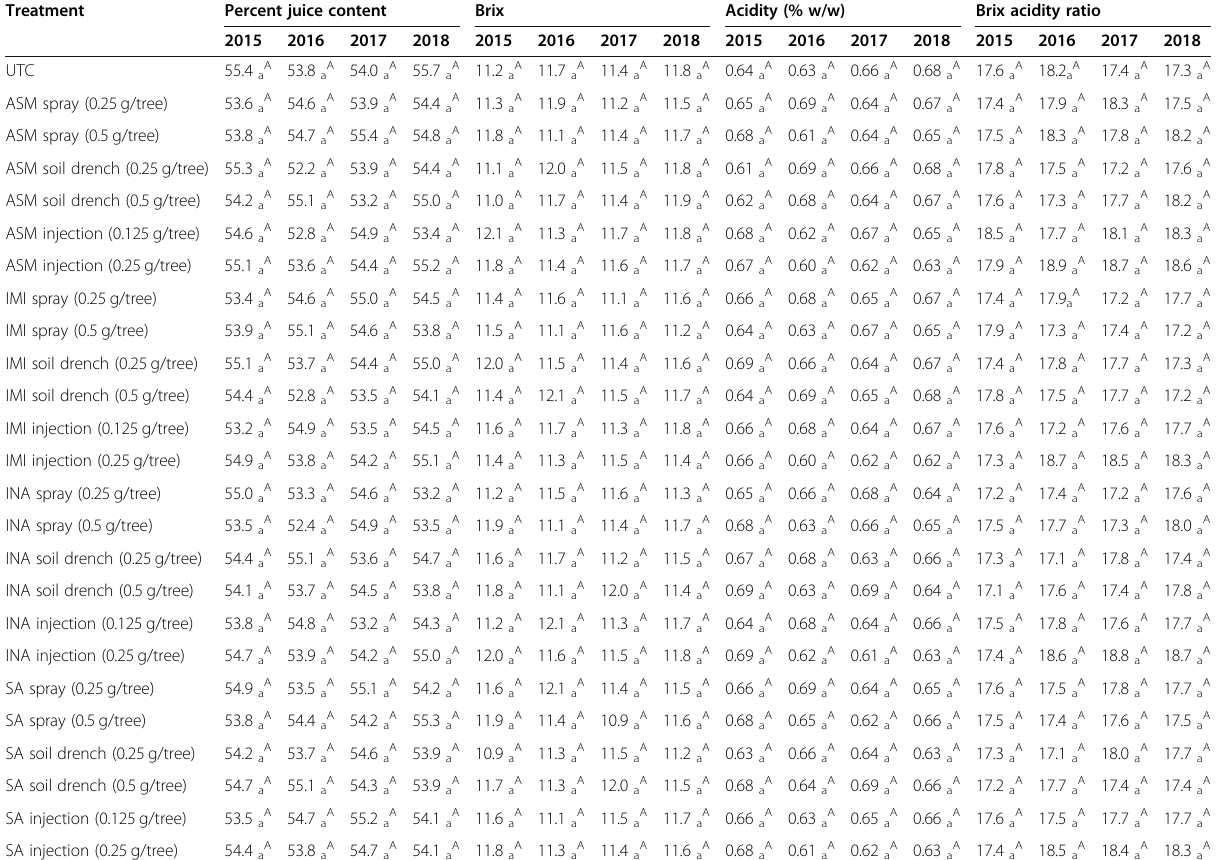
Table 4 Quality of fruit harvested from Hamlin sweet orange trees treated with SAR inducers in a three-year field trial (2015 – 2018) z Treatment Percent juice